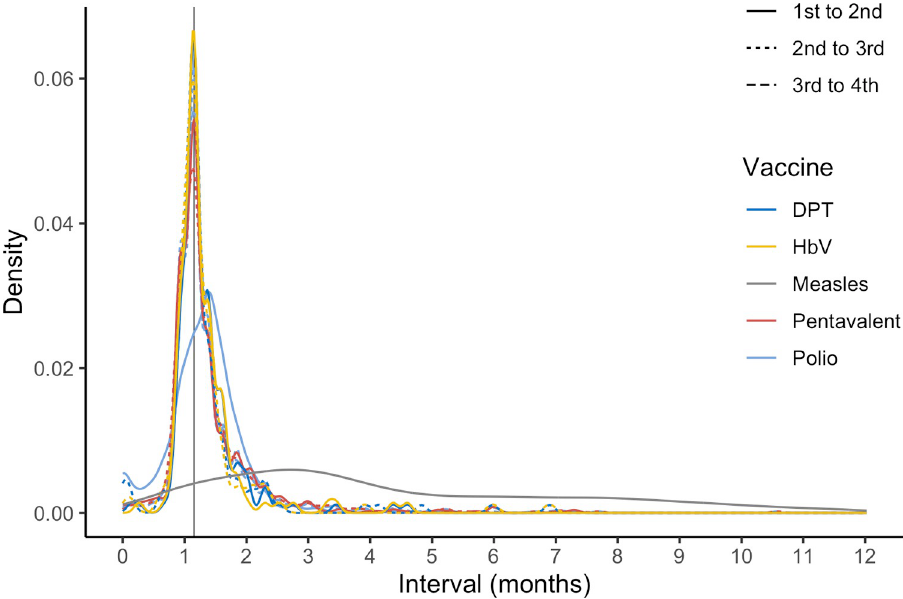
Fig 2. The density of the interval between doses for multi-dose vaccines. The line type indicates which interval (e.g., solid lines indicate the interval between the first and second dose) and the color indicates the different vaccines. The vertical line indicates a five-week